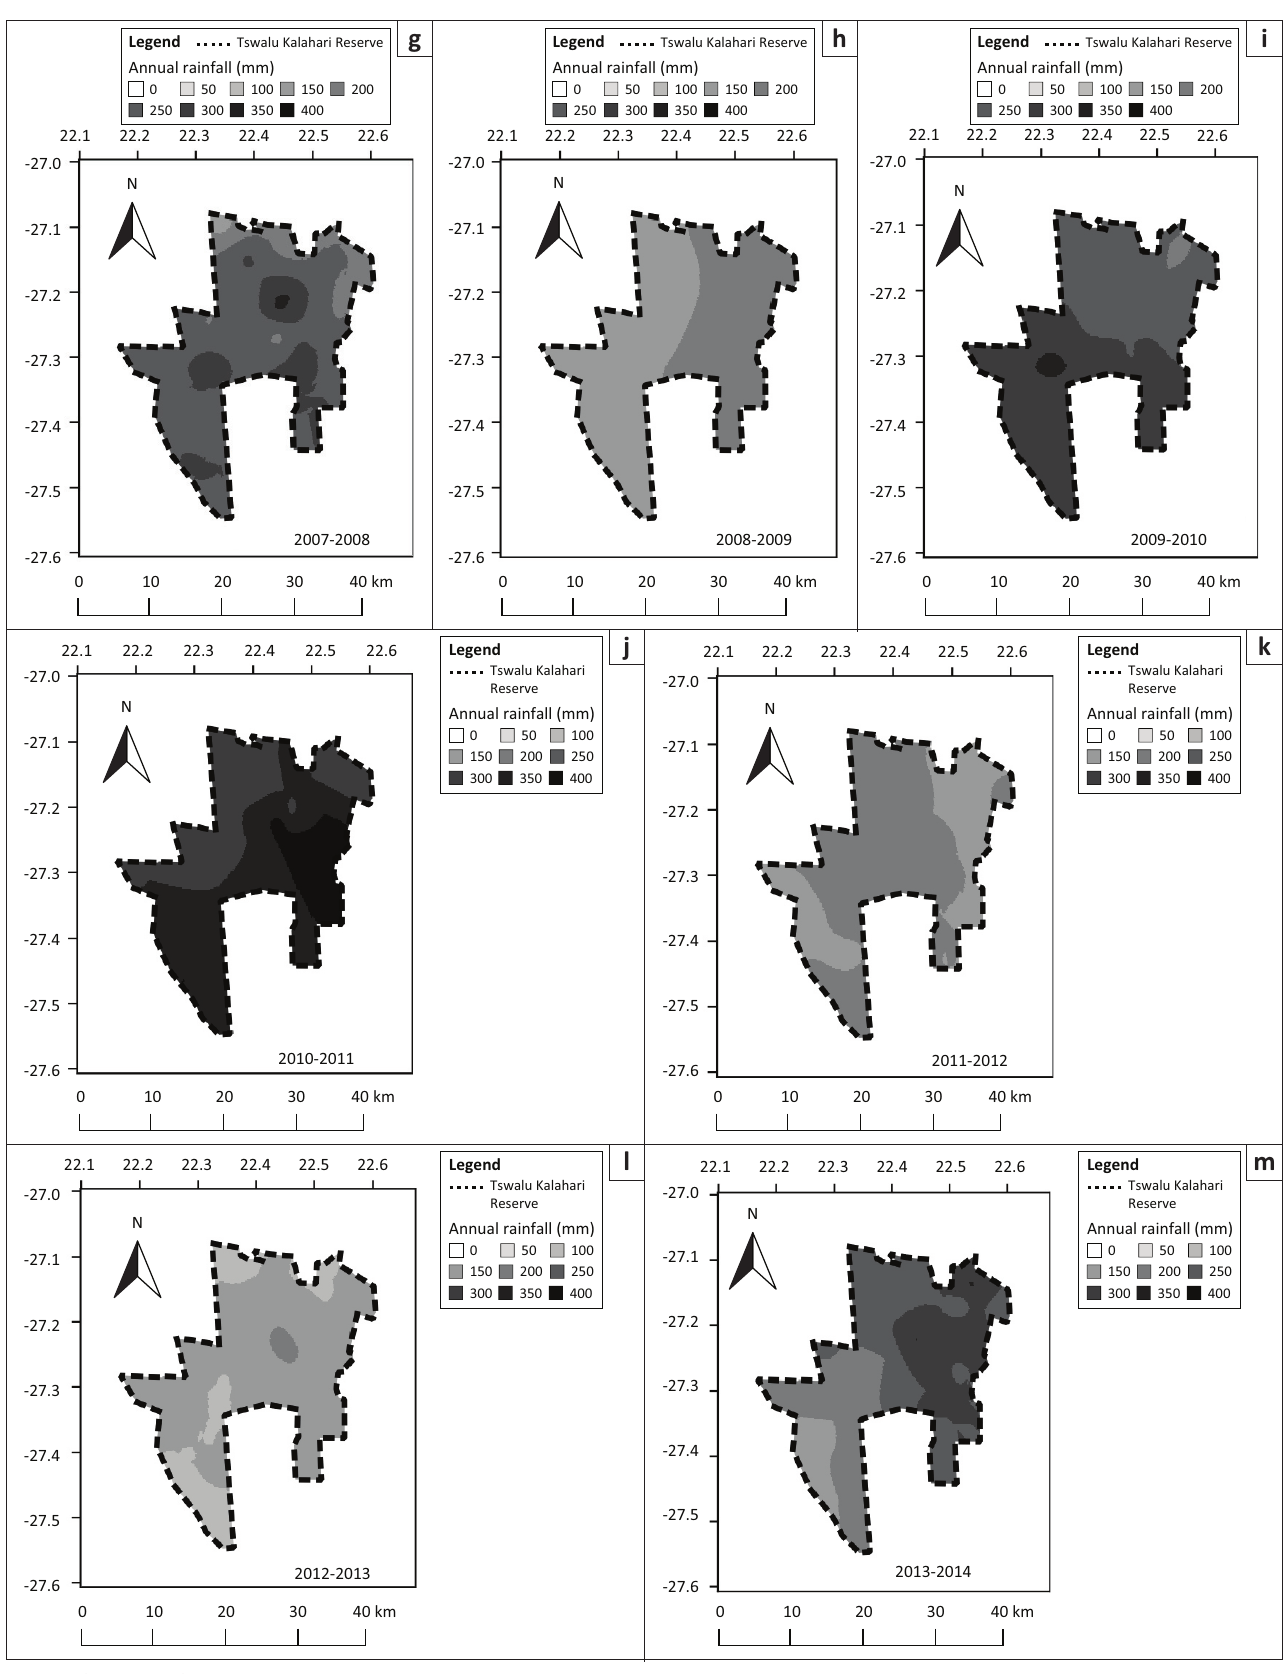
FIGURE 4 (Continues...): A composite of interpolated annual rainfall surface contour maps computed by ordinary kriging for the growth seasons (October to September) in the Tswalu Kalahari Reserve. Black dots in the 2001–2002 map represent the locations of the rainfall stations. (a) 2001–2002, (b) 2002–2003, (c)